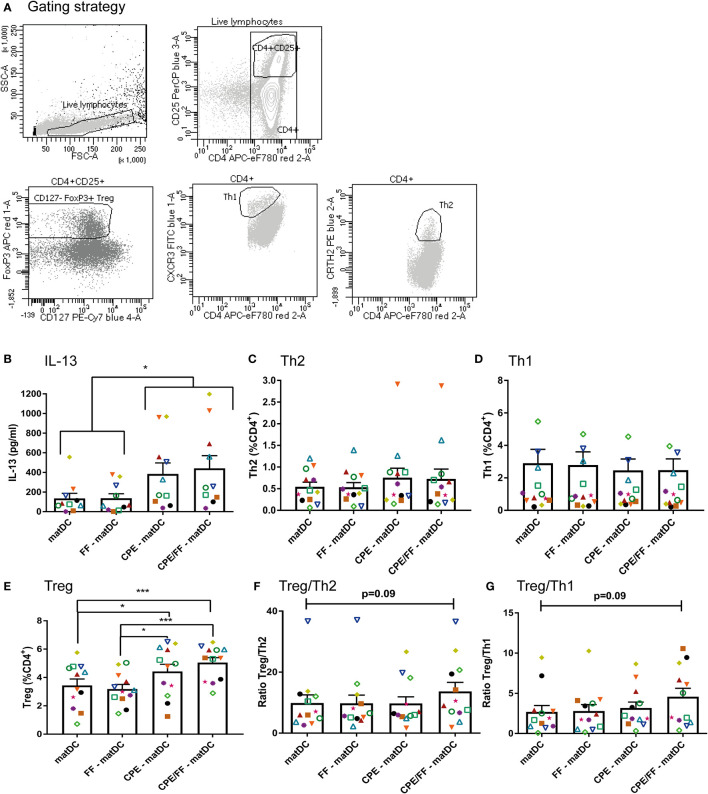
T cell polarization. Matured DCs were co-cultured for 6 to 7 days with autologous CD4+ T cells. Populations were identified as indicated (A). Only T cells co-cultured with CPE-matured DCs secreted IL-13 (B). Th2 polarization (C) and Th1 polarization (D) were not significantly affected. Treg polarization increased in the presence of CPE-matDCs +/− FF compared to matDCs and FF-matDCs (E). CPE/FF-matDCs showed a trend in increasing the ratios between Treg/Th1 and Treg/Th2 (F, G). Data are presented as mean ± SEM, *P<0.05, ***P<0.001. n=10 for IL-13 production (for 2 patients, IL-13 production was below the detection limit of the ELISA), n=12 for T cell polarization. The different symbols and colors represent the measured values of independent peanut allergic donors.